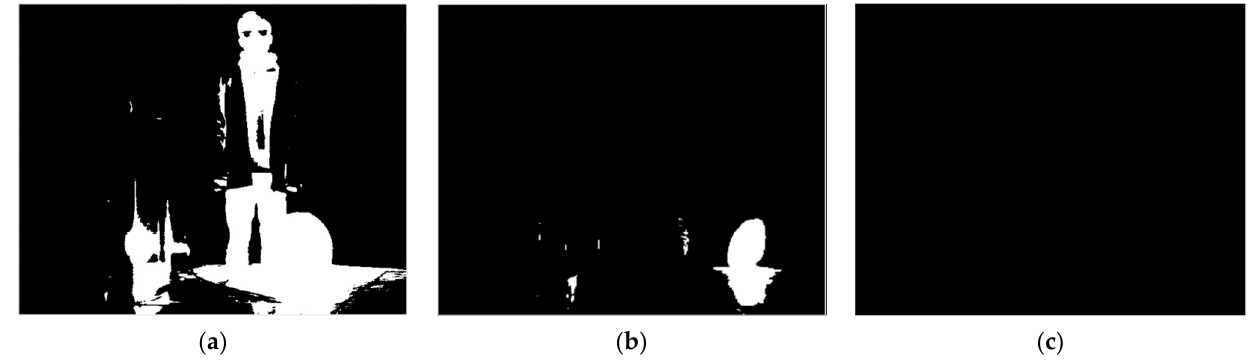
Figure 7. Segmentation results of different segmentation parameters at integration time 1995 μs: ( a ) 𝜇(1995) = 1.20; ( b ) 𝜇(1995) = 1.74; ( c ) 𝜇(1995) = 3.00. The images were divided by markers F into two major ranges, R L ( T ) and R H ( T ). The segmented images obtained in Figure 8 correspond to the integration time of the scene imaging sequence in Figure 2. It was experimentally verified that the image quality of the region (including sharpness, contrast, and good exposure) is centered on the average grayscale as a parabolic function, with an approximate opening downward. Part of the detail is not visible when the integration time is too high or too low, and the scene information characterized by the signal output is the most reliable at medium grayscale (see Debevec’s [33] elaboration for details). Therefore, the average grayscale of the region after segmentation according to the segmentation threshold should be as close to medium grayscale as possible. The construction of the objective function I be for image sequence selection is as follows: